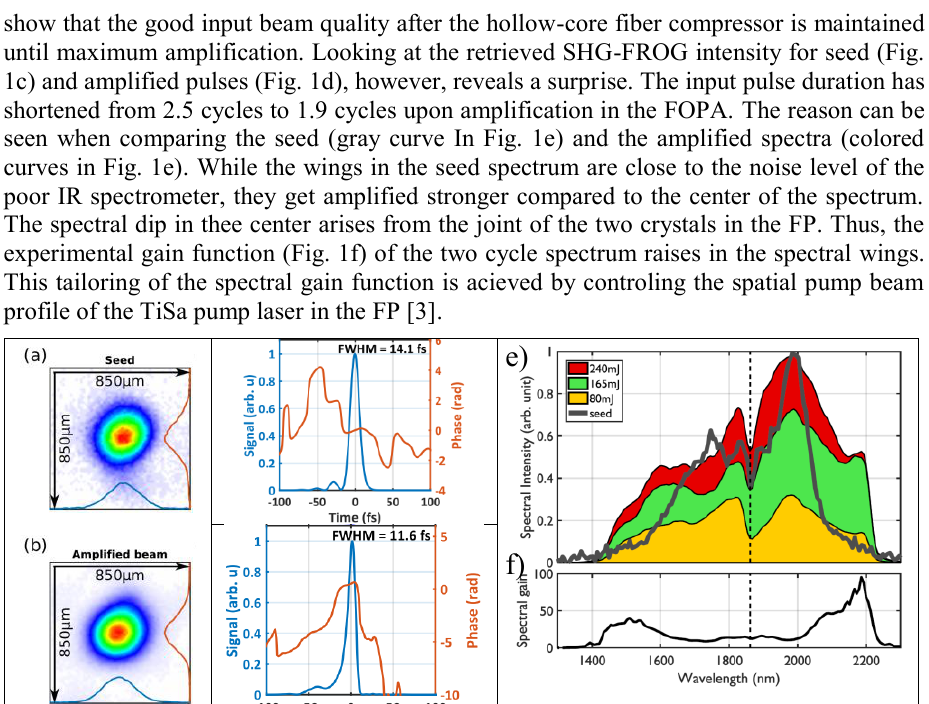
e) Fig. 1: Input and output specifications for the 1.9cycle, 2.5TW FOPA. Figs a) & b) display focal spot images, c) & d) temporal intensity profiles and e) shows the spectral gain evolution up to 240mJ of TiSa pump energy.